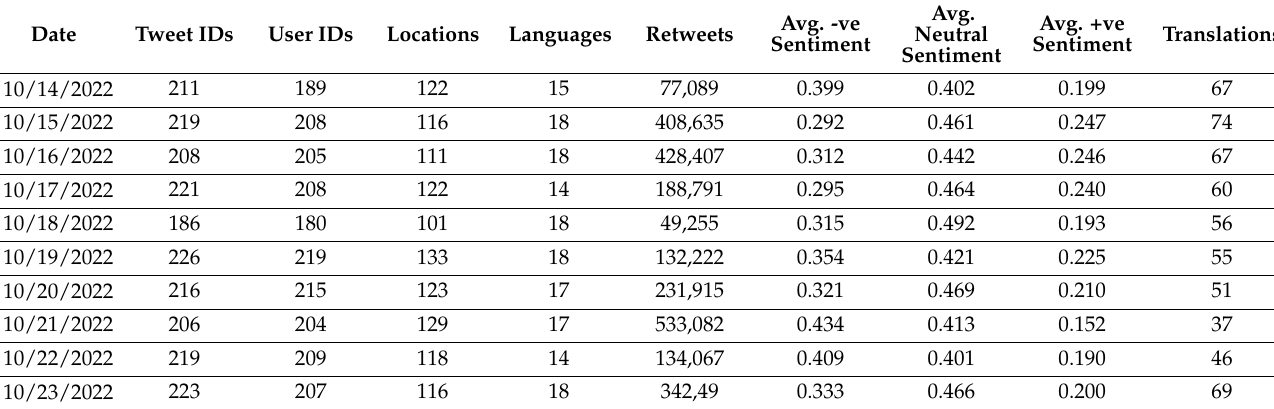
Table 6. AI-based aggregation and analysis of cyber-related